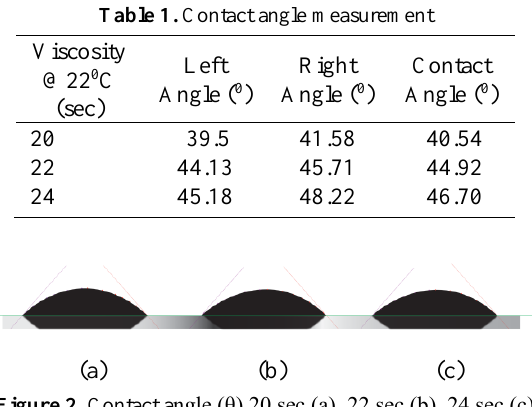
Figure 2. Contact angle (θ) 20 sec (a), 22 sec (b), 24 sec (c)